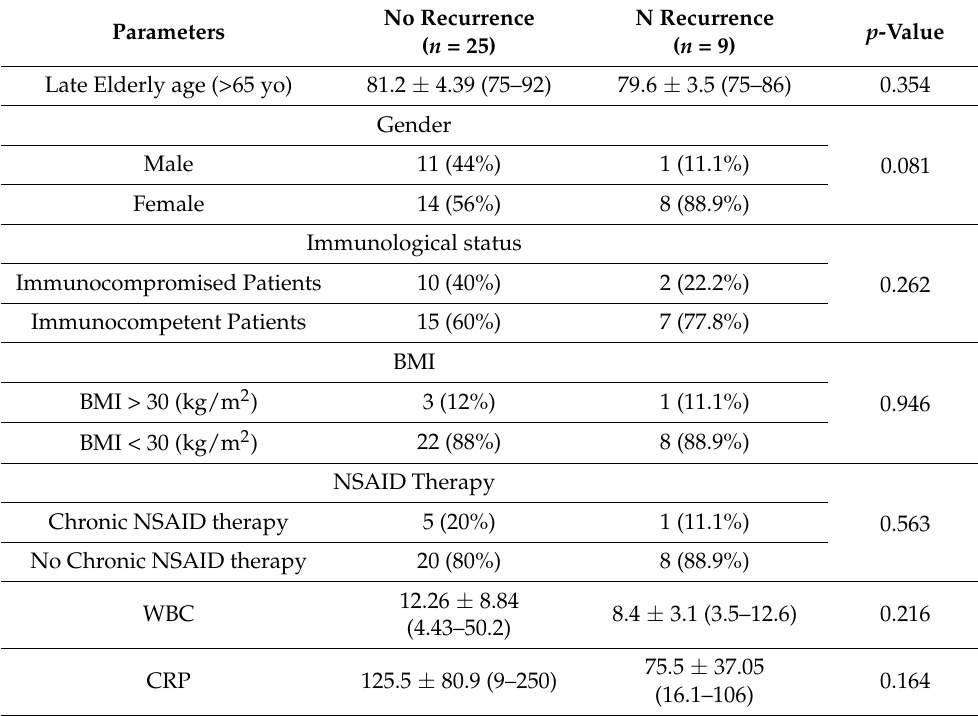
Table 4. Clinical characteristics of late elderly patients with and without